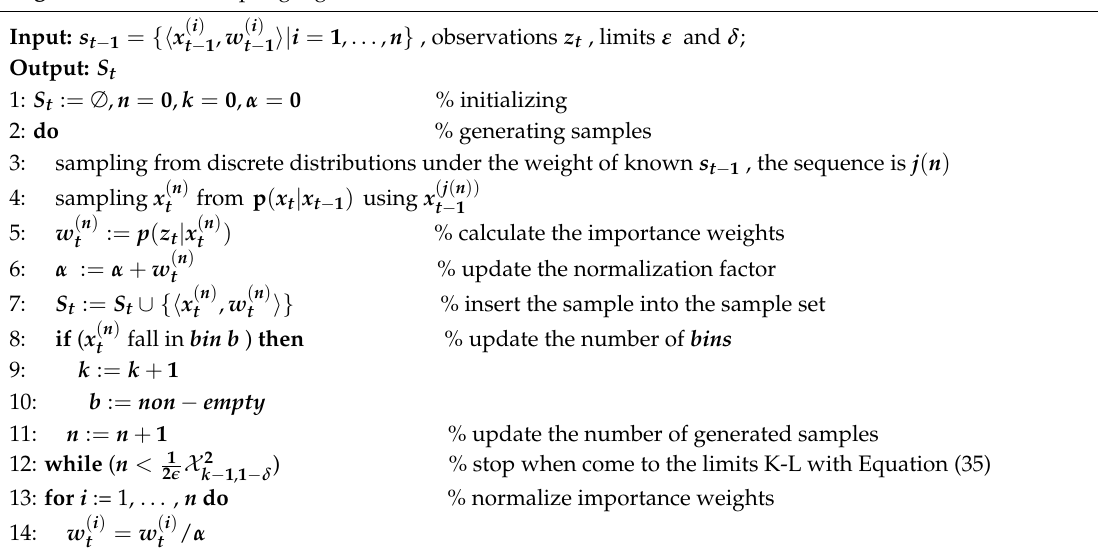
Algorithm 3. KLD sampling algorithm